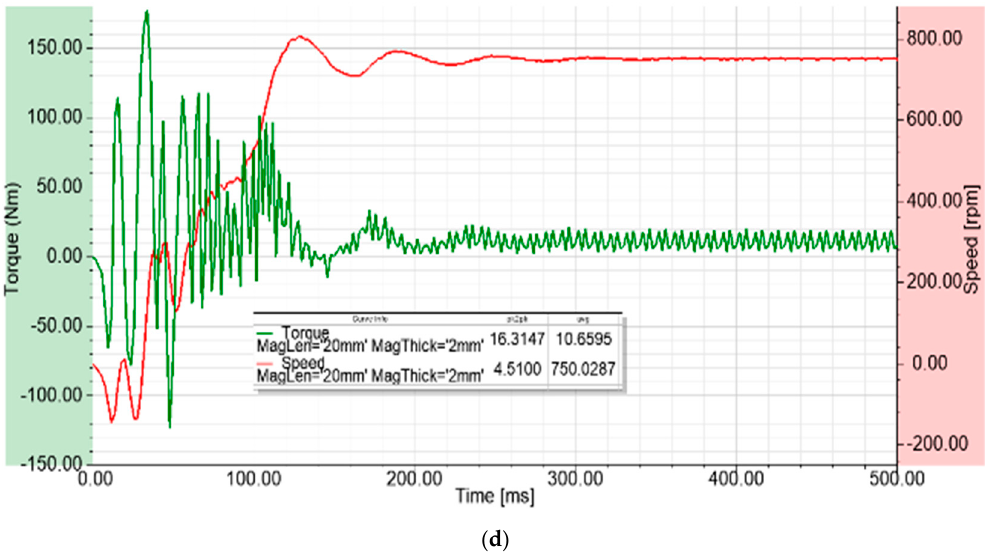
Figure 5. Simulation results for line-start and steady-state operation under the rated load (10 Nm) for optimum magnet size of each configuration. ( a ) Type-A, ( b ) Type-B, ( c ) Type-C, ( d ) Type-D.